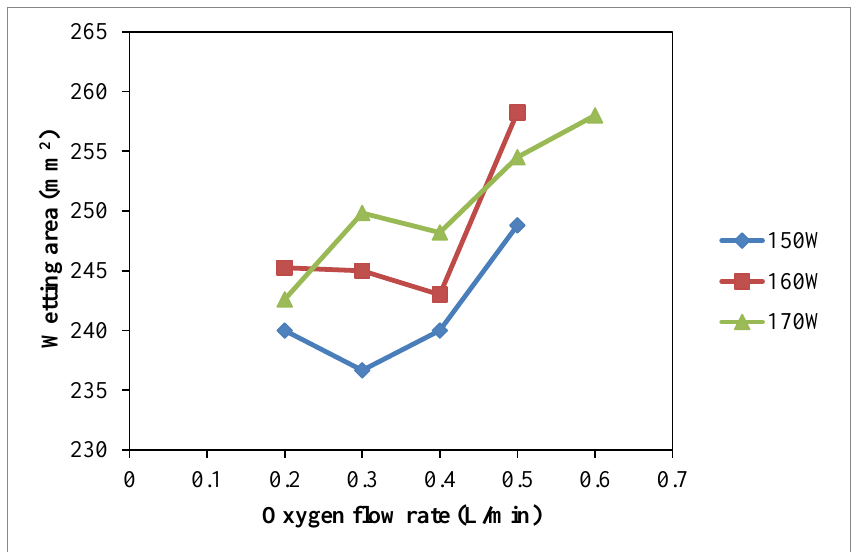
Figure 9. Effect of oxygen flow rate on wetting area (Oxygen flow rate: 0.2 L/min, 0.3 L/min, 0.4 L/min, 0.5 L/min and 0.6 L/min; Discharge power: 150 W, 160 W and 170 W; Jet travelling speed: 5 mm/s and Jet-to-substrate distance: 3 mm).